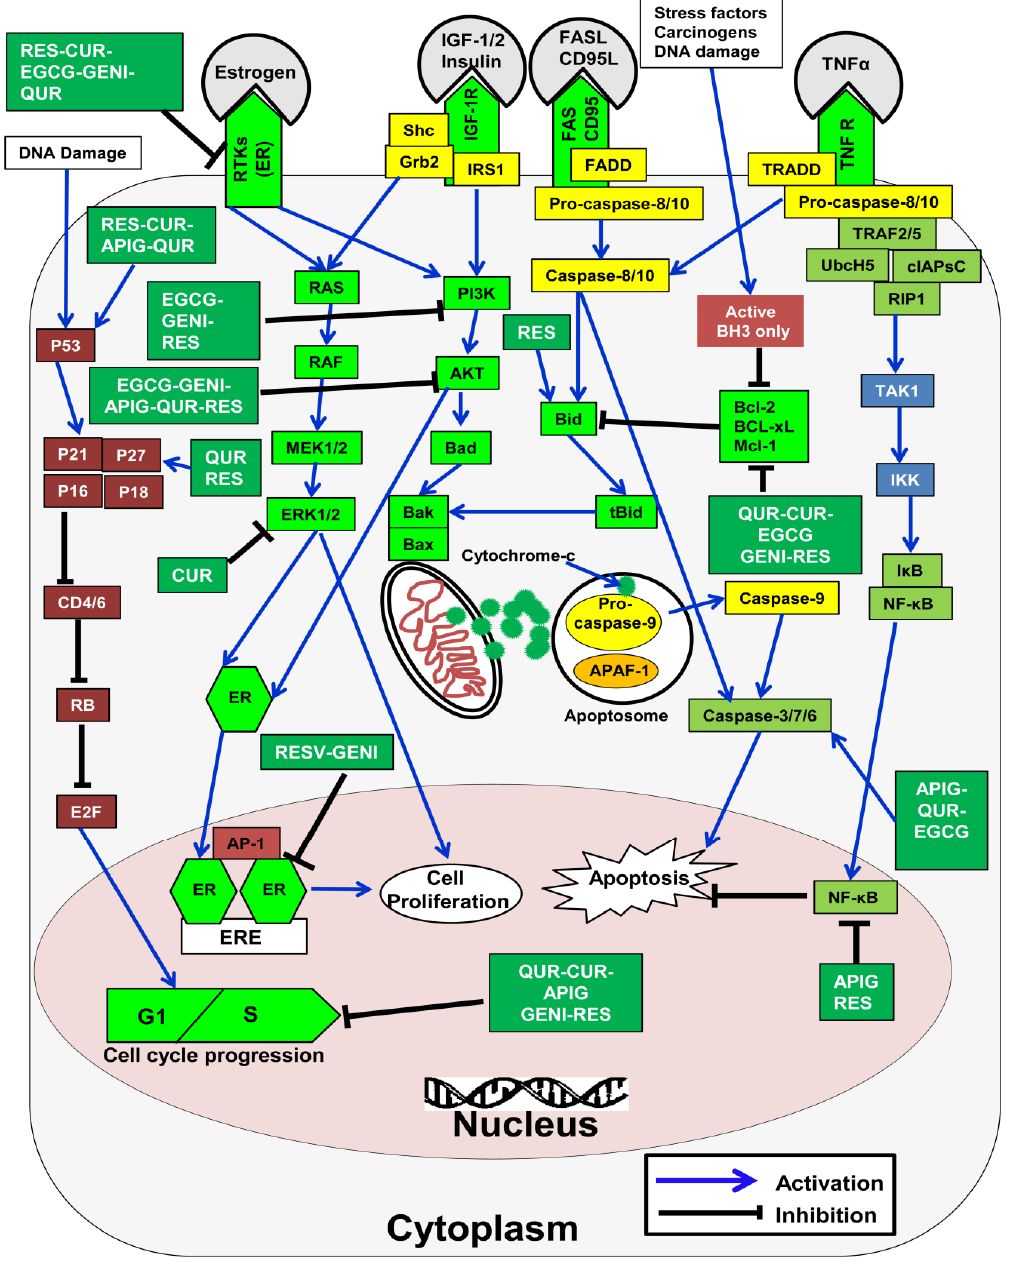
Figure 5. Comprehensive representation summarizing the possible mechanisms of action of polyphenols against breast cancer. The anti ‐ cancer activity of polyphenols is mediated via the regulation of various signaling pathways, such as intrinsic and extrinsic apoptotic pathways, estrogen ‐ related signaling pathways, cell cycle arrest, and inflammation ‐ related signaling pathways. RES, resveratrol; CUR, curcumin; GENI, genistein; QUR, quercetin; APIG, apigenin.